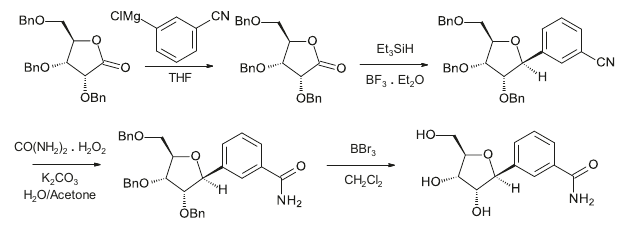
Fig. 6 Synthesis of 3-(1 ’ - β -D-Ribofuranosyl)benzamide (benzamide riboside). Synthesis adapted from 48